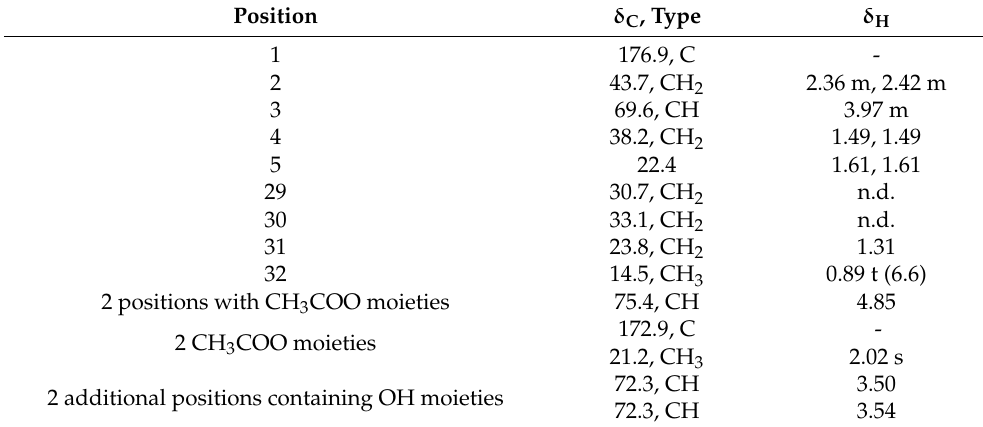
Table 4. 1 H and 13 C NMR shifts for compound 46 (MeOH-d 4 , 700 and 175 MHz,